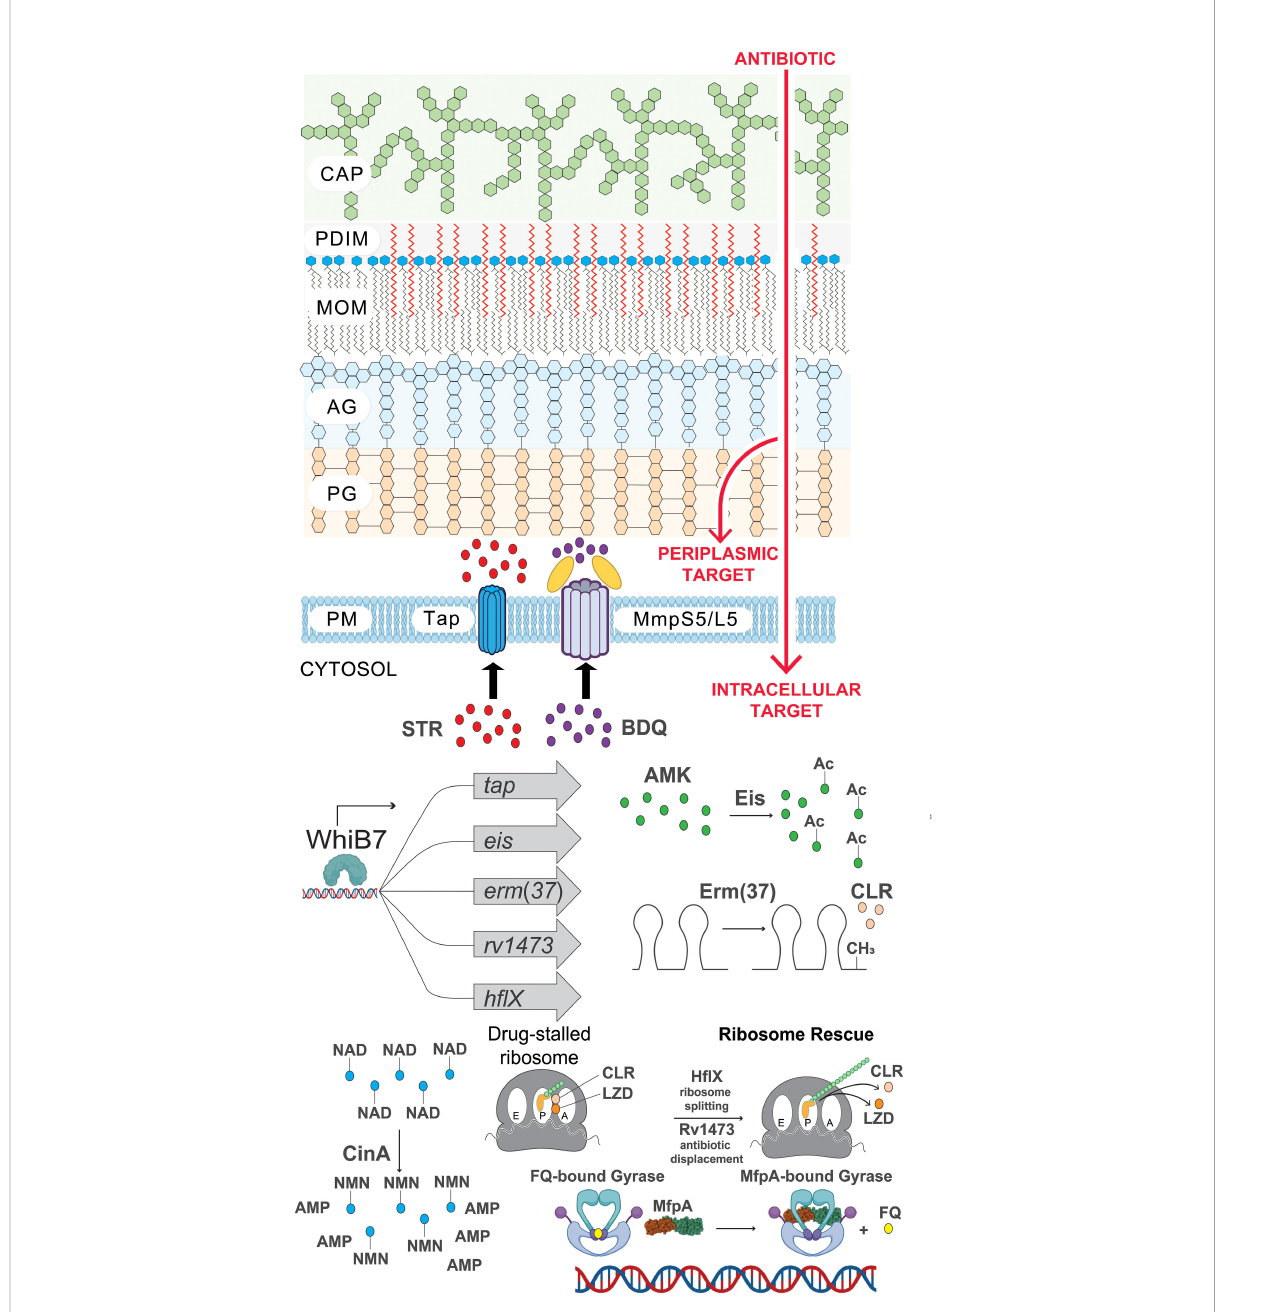
mononucleotide; AMP, adenosine monophosphate. Figure graphics were generated using Biorender